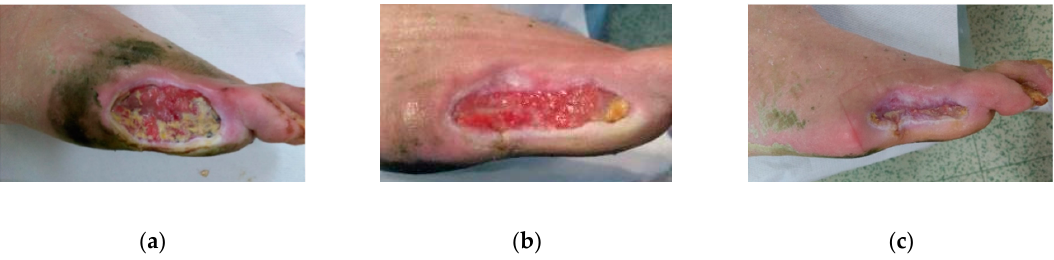
Figure 3. Case 3: ( a ) the wound at the start of MGH therapy (day 0); ( b ) progressed wound healing with healthy granulation tissue after three weeks of MGH therapy; ( c ) advanced healing of the wound after nine weeks of MGH therapy.